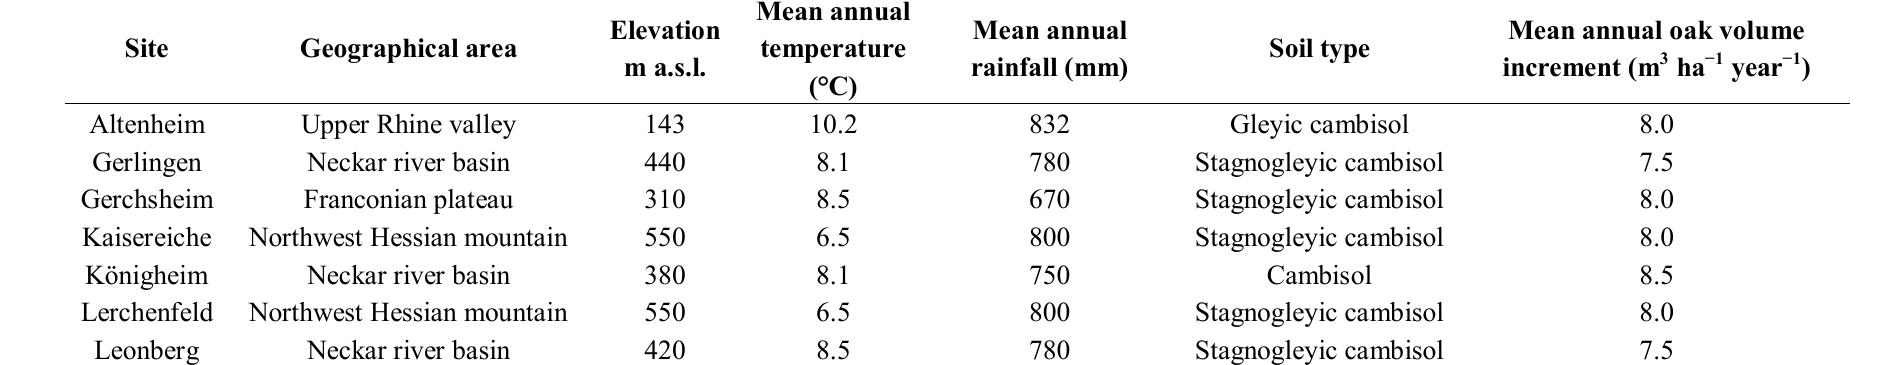
Table 1. Descriptions and location of investigated cluster planting sites.